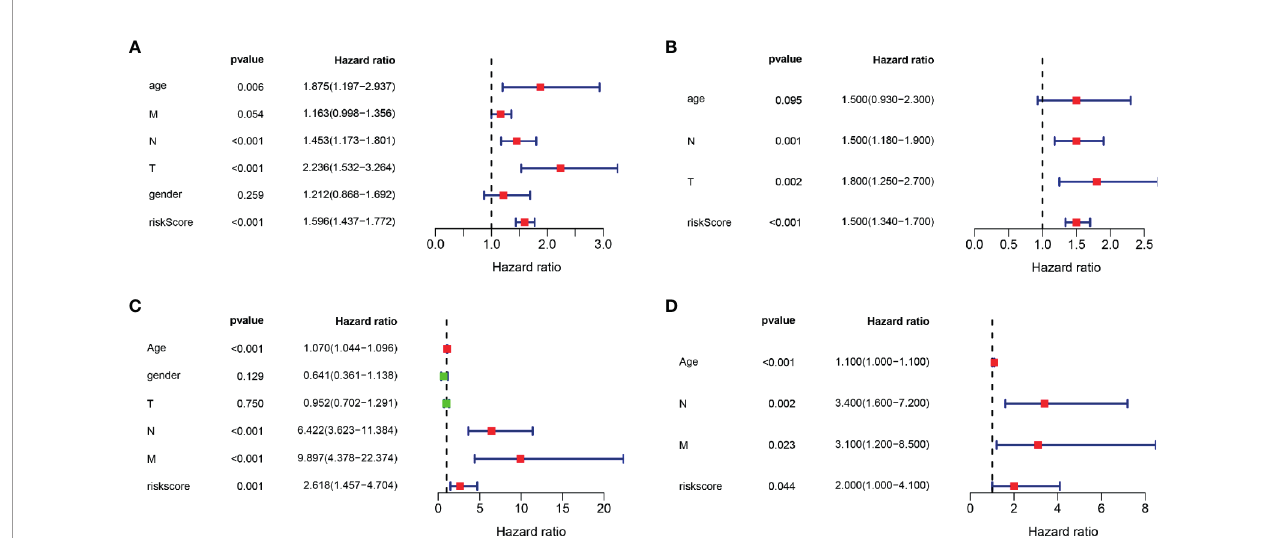
FIGURE 6 | Univariate and multivariate Cox regression analyses. Results showing the signature-based risk score was an independent predictor of OS. (A) The univariate Cox regression analysis in the TCGA cohort. (B) The multivariate Cox regression analysis in the TCGA cohort. (C) The univariate Cox regression analysis in the GEO cohort. (D) The multivariate Cox regression analysis in the GEO cohort.